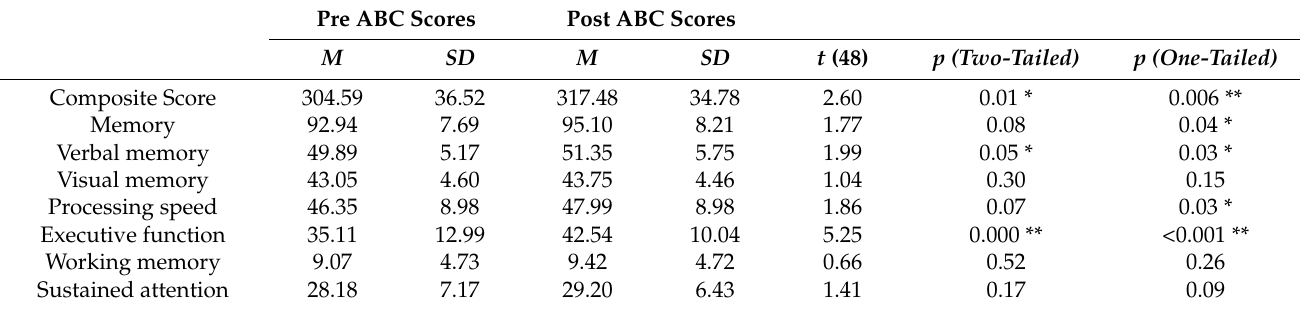
Table 2. Pre- and post-cognitive assessment results for the ABC (treatment) group.